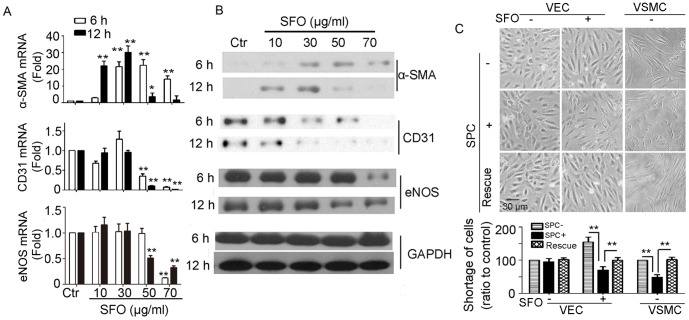
SFO promoted endothelial–mesenchymal transition (EndoMT) in HUVECs.HUVECs were exposed to 10–70 µg/ml SFO in normal medium. (A) qPCR analysis of mRNA expression of α-SMA, CD31 and eNOS in HUVECs treated with SFO at 3, 6 and 12 h. Expression was normalized to that of GAPDH. *p<0.05;**p<0.01 vs. Ctr, n = 4. (B) Western blot analysis of protein expression of α-SMA, CD31 and eNOS in HUVECs treated with SFO at 6 and 12 h. Results are representative of 3 independent experiments. (C) HUVECs were treated with ethanol (Control) or 50 µg/ml of SFO for 6 h, then exposed to 30 µM sphingosylphosphorylcholine (SPC) for 1 h, with or without rescue for 1 h, and contraction of cells was calculated. VSMC stimulated with SPC was as a positive control (**p<0.01, n = 3).